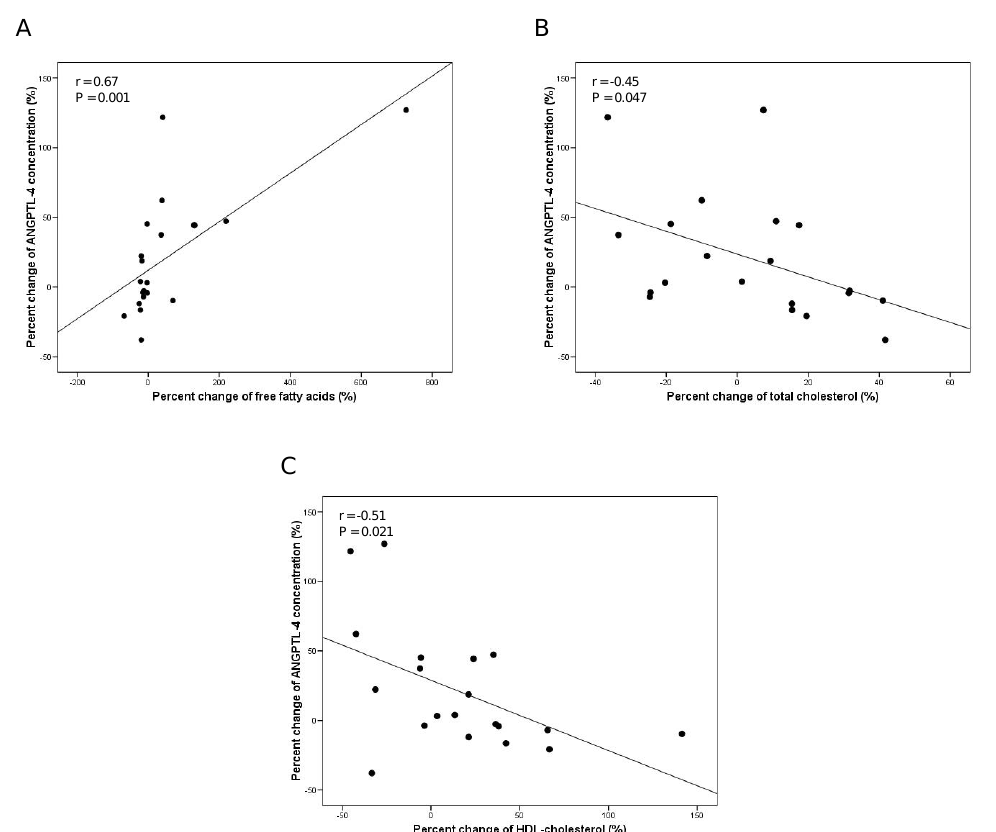
Figure 3. Correlation analysis of the longitudinal study population. Bivariate correlation between ANGPTL-4 percent change and percent change of: FFA ( A ); total cholesterol ( B ); and HDL-cholesterol ( C